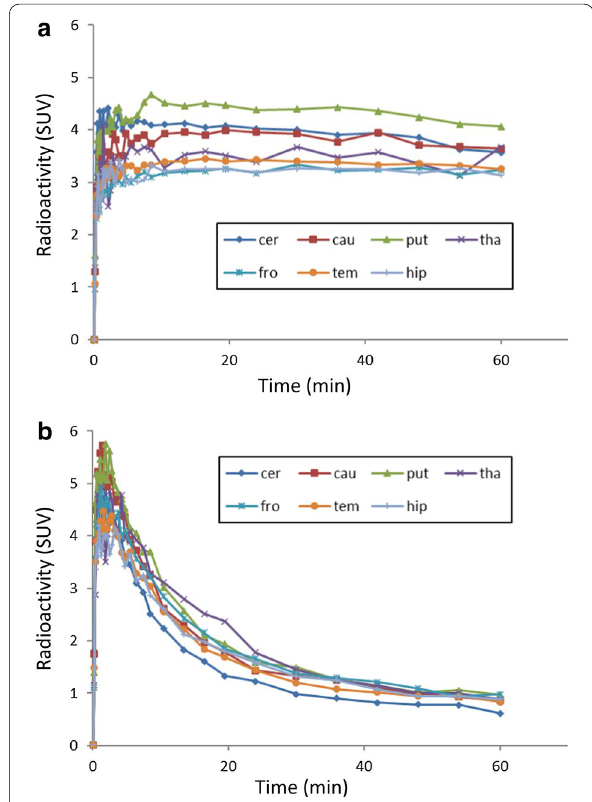
Fig. 2 Representative time activity curves of [ 11 C]PF-06809247 in the NHP brain at a baseline and b following pretreatment with a selective